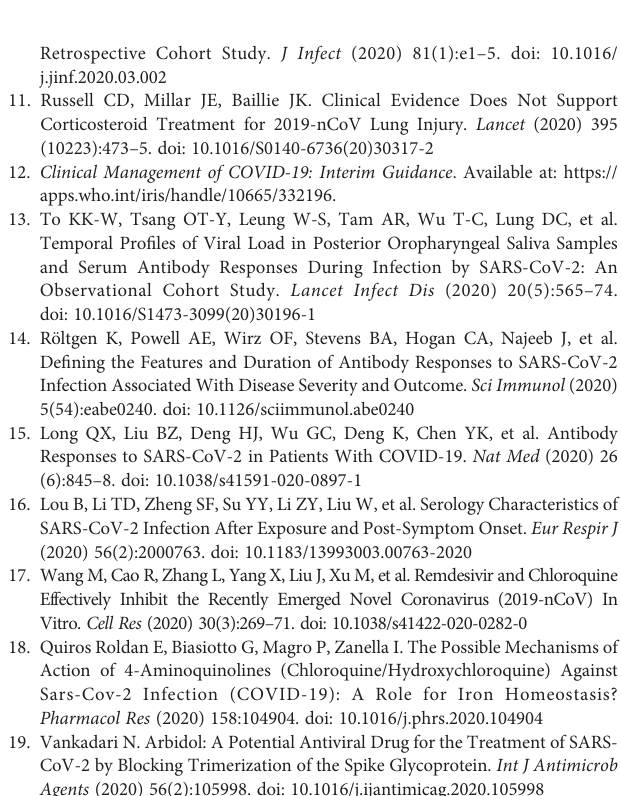
Supplementary Figure 1 | COVID-19 Patients Developed SARS-CoV-2 Speci fi c Antibodies. Comparison of The IgG and IgM antibody titer against S1 protein or RBD between COVID-19 patients (n=25) and healthy people (n=13). The antibody titers of COVID-19 patients were collected two weeks after symptom onset. Supplementary Figure 2 | Detection of IgG and IgM Antibody against S Protein or RBD in COVID-19 Patient. Plasma were collected at different time points after syndrome onset. The titers of IgG or IgM antibody binding to S1 protein or RBD in 21 COVID-19 patient plasma are shown. The green dotted line represents the time point when the patient ’ s nucleic acid turns negative while the orange dotted line represents the time point when the patient ’ s nucleic acid turns positive. The red process bar indicatesthat the patient ’ s nucleicacid ispositive, andthe blue indicate a negative result. Supplementary Figure 3 | The Nucleic Acid Ct Value in Throat Swab was Positively Correlated with the Anti-S and Anti-RBD IgG and IgM Antibody Titer. The titers of IgG or IgM antibody against S1 protein or RBD between 8-21 days from symptom onset and the nucleic acid Ct value in throat swab of each patient during their hospitalization period were collected. Fifty samples were included in this fi gure. Supplementary Figure 4 | The anti-S1 or anti-RBD IgG and IgM antibody titers were comparable in the severe and mild group between 8-63 days from symptom onset. The patients were grouped by disease symptom. The titers of IgG and IgM antibody against S1 (A) protein or RBD (B) between 8-63 days from symptom onset were collected and